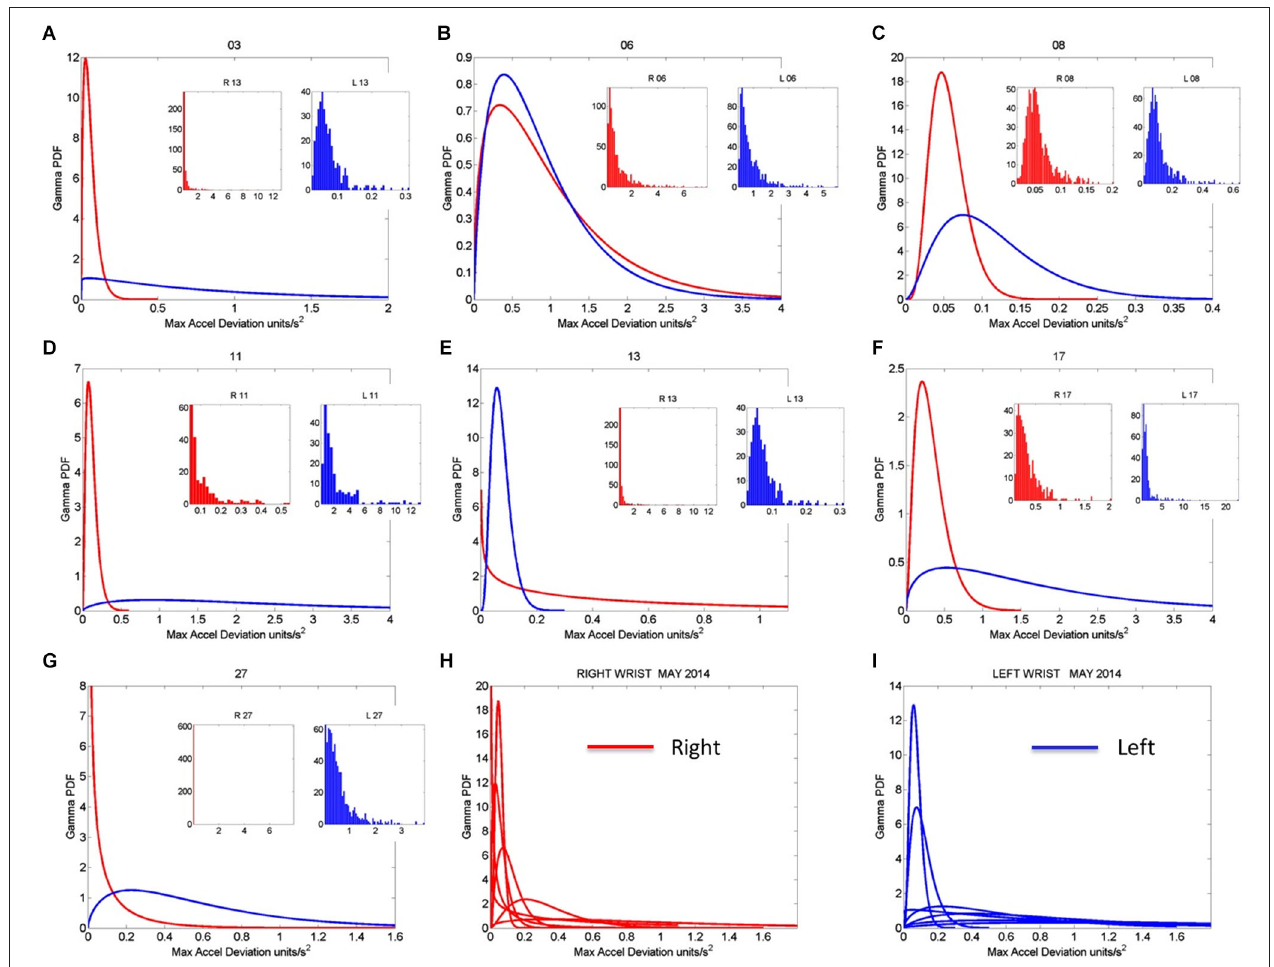
estimated shape and scale parameters of the continuous Gamma family of probability distributions. (H,I) Summary of the right (red) and left (blue) wrist Gamma pdf patterns obtained within the temperature values determined using the methods of Figure 2 according to the minimal noise-to-signal values within the temperature ranges from the sensor’s readings. Each number on the graph represents the day of the recording in the month of